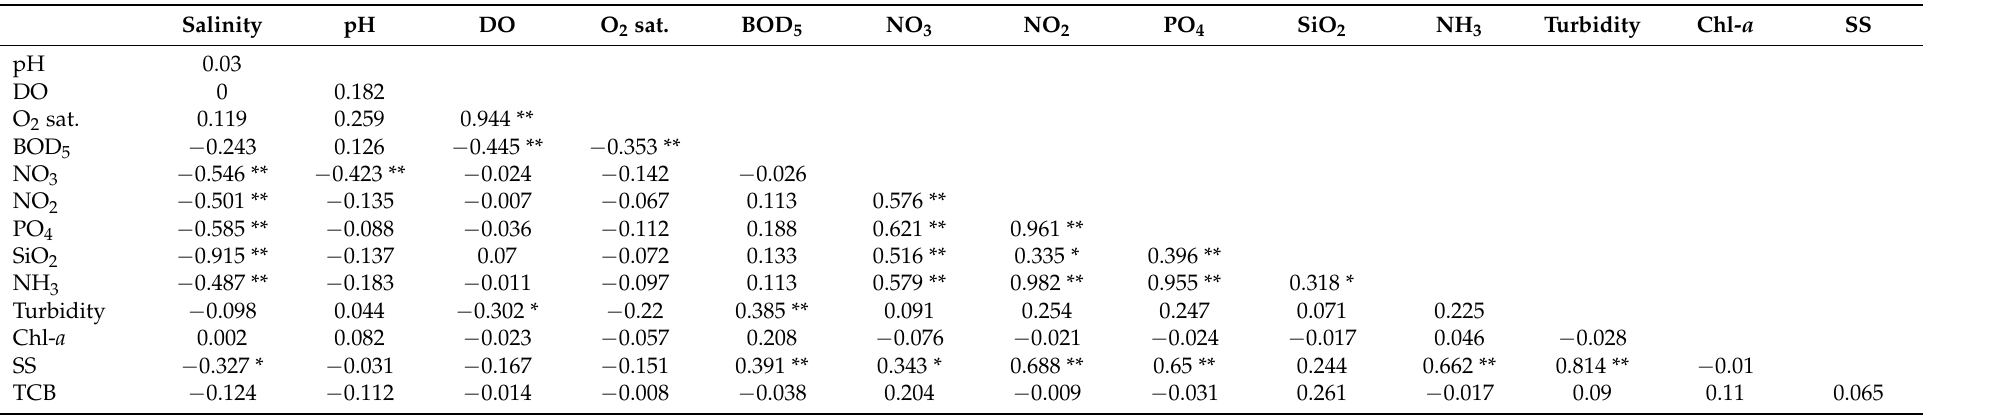
Table 1. Correlation coefficients (R) among seawater quality parameters. DO: dissolved oxygen; O 2 sat.: oxygen saturation; Chl- a : chlorophyll a ; SS: